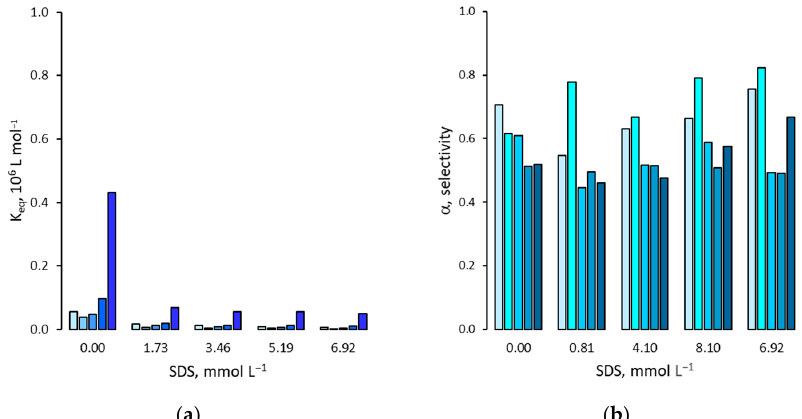
Figure 8. ( a ) Binding affinity of 2,4-D for the MIP in presence of increasing amounts of SDS; ( b ) Binding selectivity. For each group of bars from left to right: water molar fraction from 0 (pure acetonitrile) to 0.24, 0.42, 0.66 and 0.81.